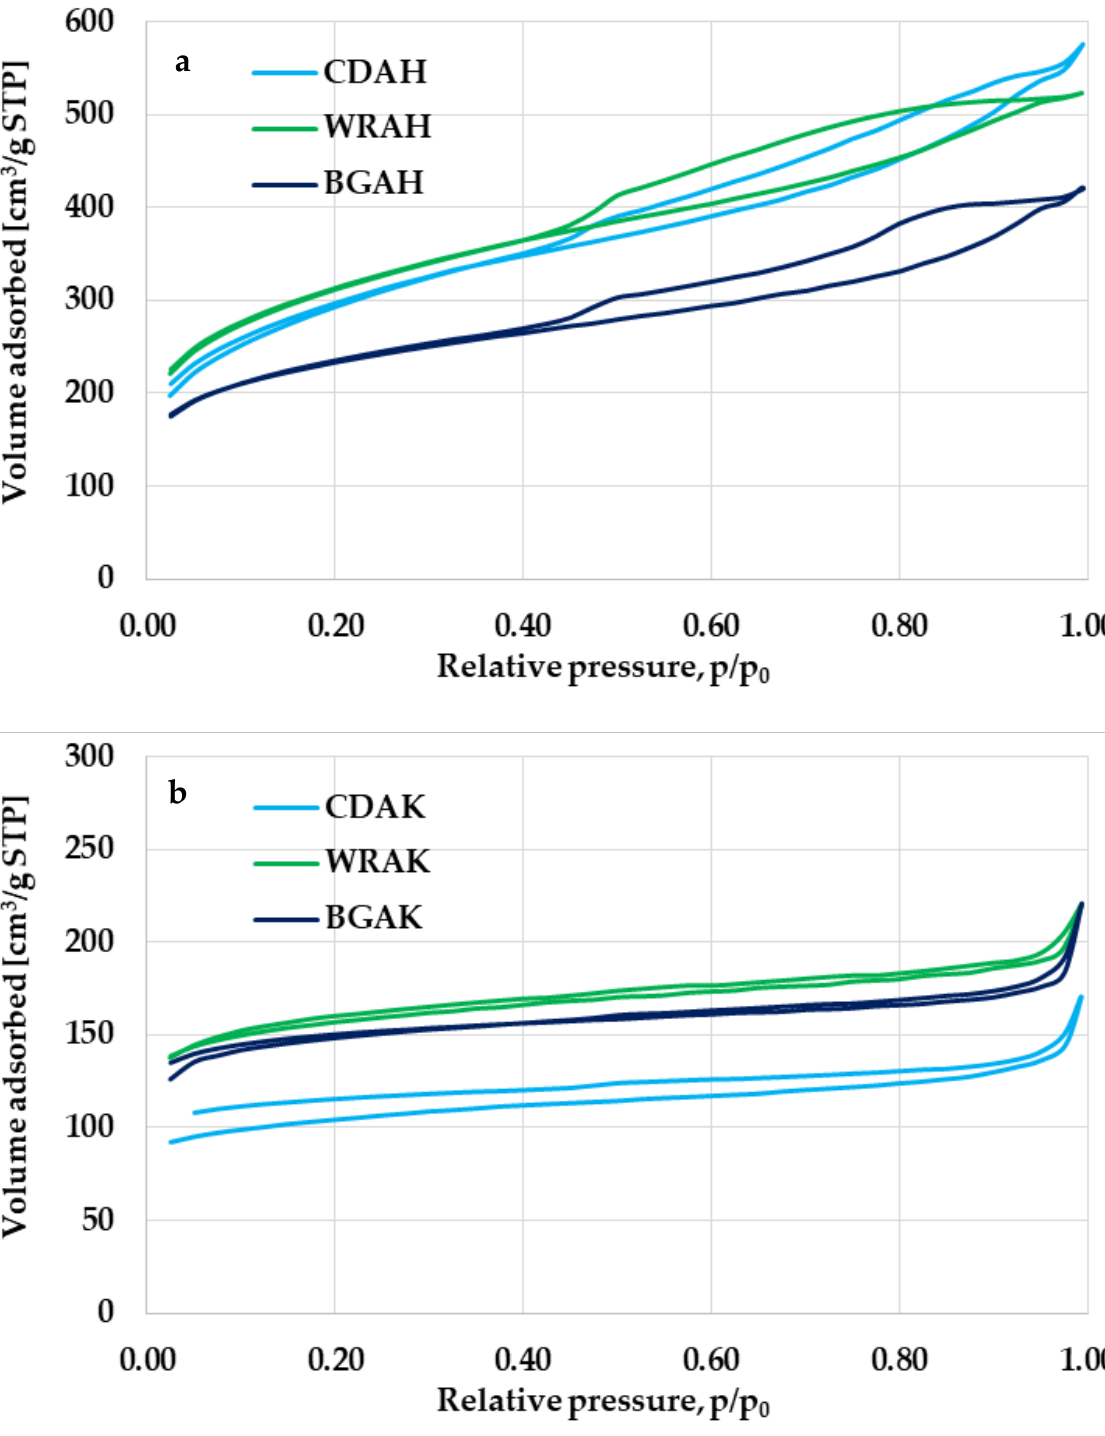
Figure 2. Low-temperature nitrogen adsorption/desorption isotherms of the samples activated with H 3 PO 4 ( a ) and K 2 CO 3 ( b ).